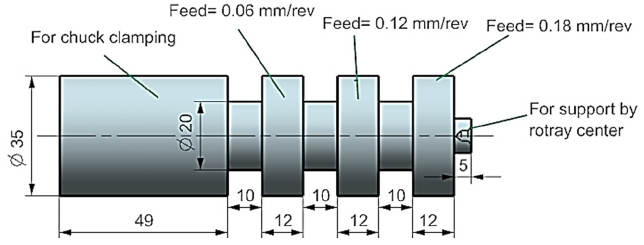
Figure 1. AISI 1045 specimen used for experimentation.